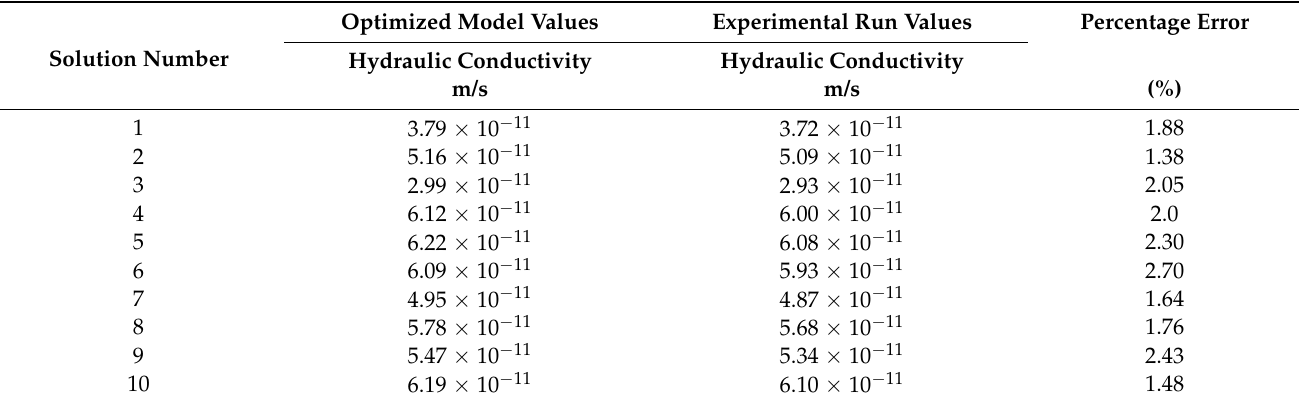
Table 8. Validation of optimized model response by experimental runs indicating percentage